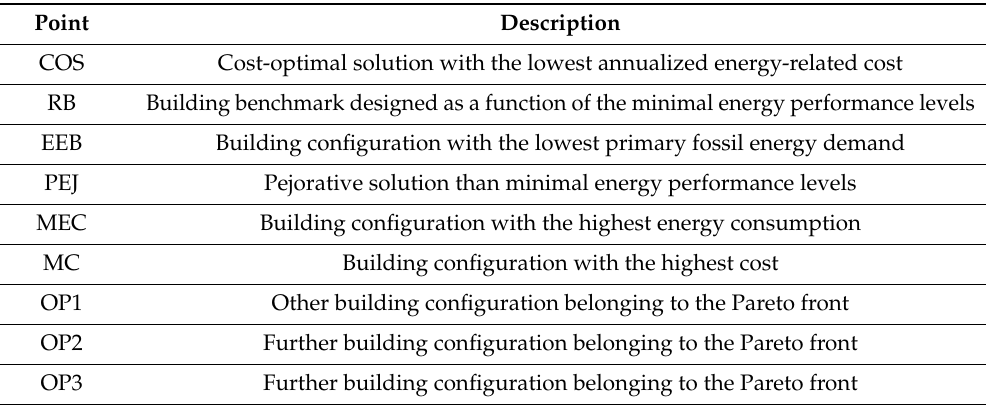
Table 9. Points indicating of the more representative building configurations.